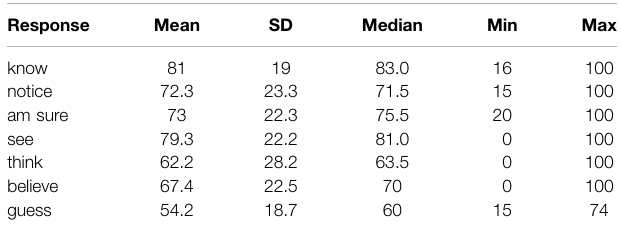
TABLE 2 | Mean evidentiality ratings by utterance for the experiment